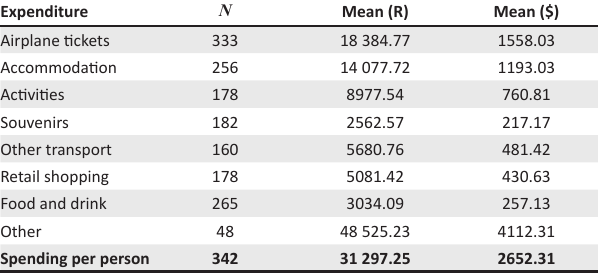
TABLE 4: Mean expenditure on selected items.